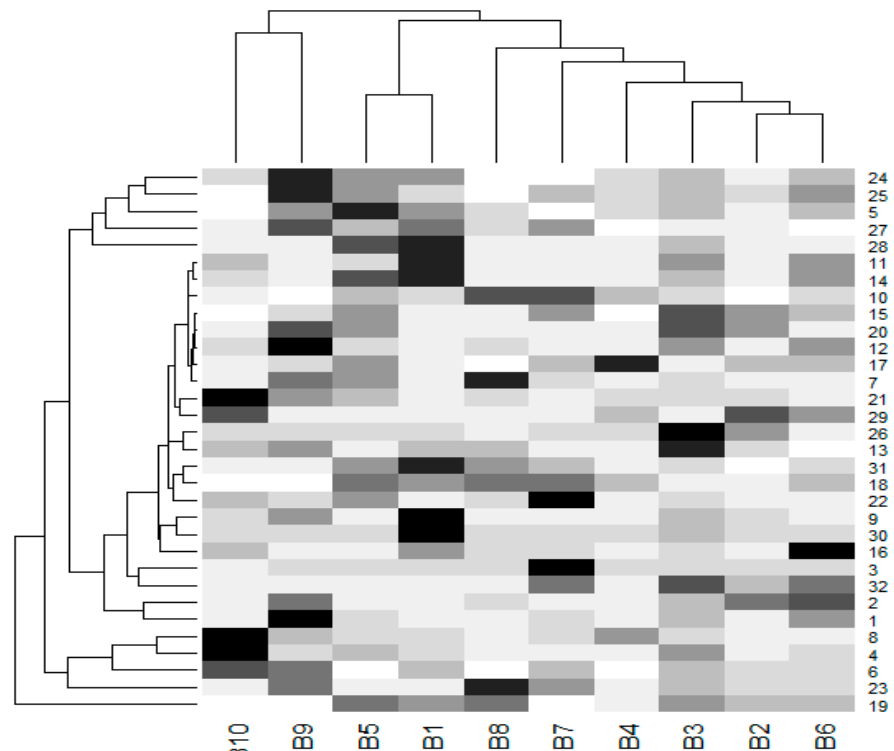
Figure 7. A dendrogram was prepared from the percentages of melanin pigment (mean values) found in 32 organs of each chicken. The cells are colored according to the percentage of melanin pigment. The highest melanin pigment is represented by the color black, while the lowest melanin pigment is presented in super light gray. A tree on the column represents a clustered group of chickens, while a tree on the row represents a clustered group of organs. (B-1-10, B1-5 were male subjects and B6-10 were female subjects). The liver, beak, comb, wattle, scale, and feathers were not included in this dendrogram. (1 = brain, 2 = spinal cord, 3 = sciatic nerve, 4 = larynx, 5 = trachea, 6 = syrinx, 7 = lung, 8 = heart, 9 = pericardium, 10 = aorta, 11 = brachial vein, 12 = kidney, 13 = cloaca, 14 = oviduct, 15 = testis, 16 = gastrocnemius muscle, 17 = femur, 18 = tongue, 19 = esophagus, 20 = crop, 21 = proventriculus, 22 = gizzard, 23 = duodenum, 24 = jejunum, 25 = ileum, 26 = cecum, 27 = pancreas, 28 = gall bladder, 29 = omentum, 30 = abdominal fat, 31 = spleen, 32 = skin).